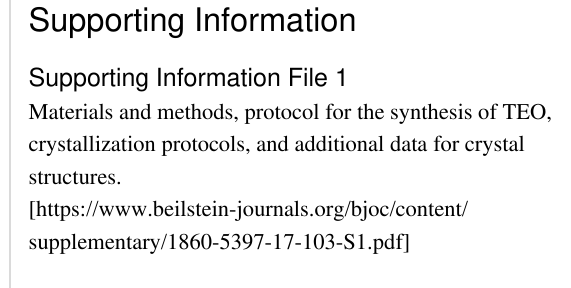
ment quickly, without full desolvation, and once the crystal lattice has formed, the guest molecule is unable to escape from it, blocking the path to solvent-free crystals that may be thermo- dynamically more favorable. As noted above, tightly packed solvent-free crystal systems exist for TAAs